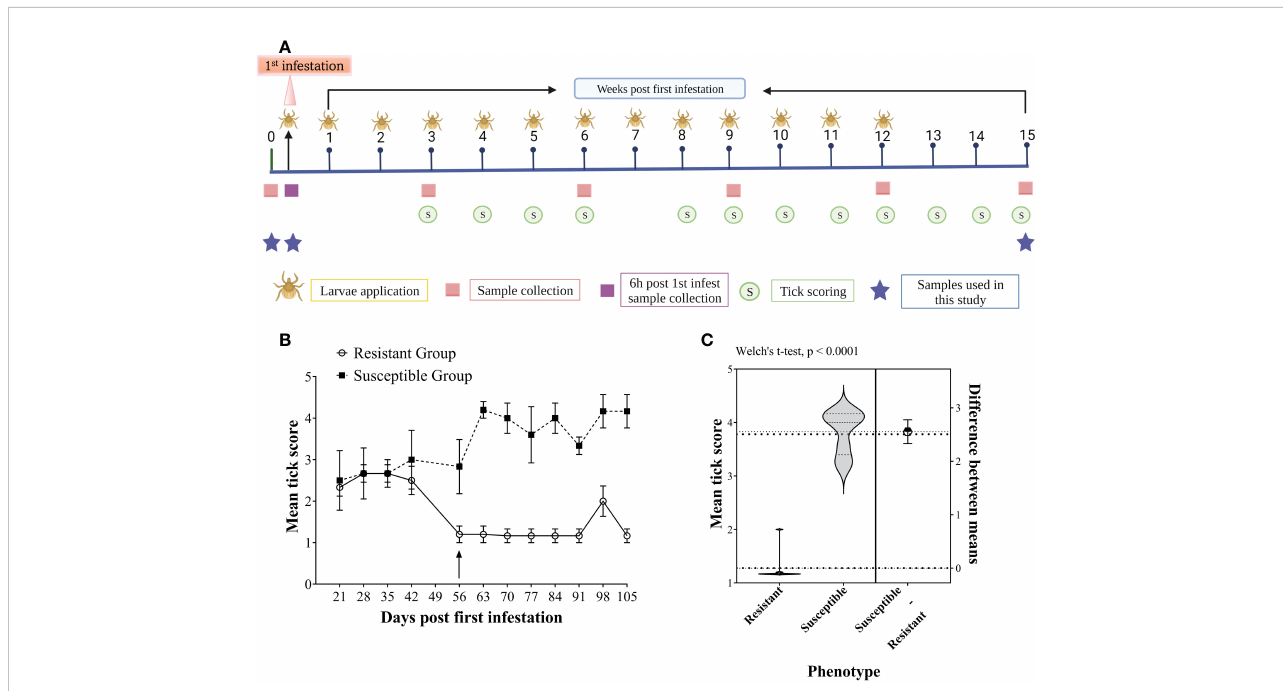
FIGURE 1 Experimental plan of the study (A) , representing the study design timeline of the arti fi cial tick infestations showing the frequency of larvae applications (larvae), tick scoring (circles), sampling (squares) and selected sampling timepoints for this study (stars). Tick scoring for host resistance phenotyping of Brangus steers, (B) Weekly group mean tick scores for the six most susceptible (dotted line, squares) and six most resistant (solid line, circles) animals measured from 21 days to 105 days post- fi rst infestation. The arrow shows the time at which a clear separation of the two groups was evident from the mean tick scores. The values are presented as the group mean ± SEM. (C) Violin plots showing the comparison of mean tick score (week 8-15) values between resistant and susceptible host phenotype compared with Welch ’ s t-test (P <